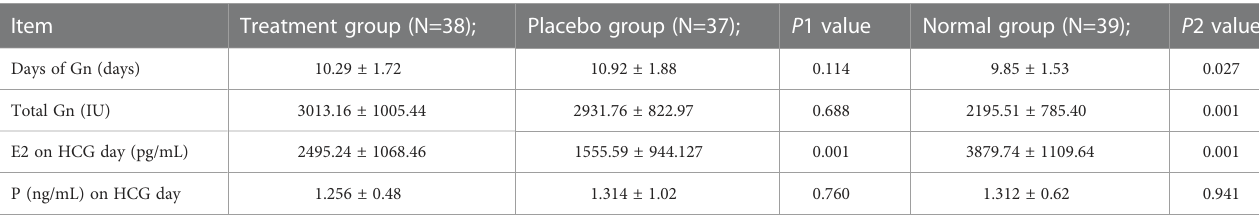
TABLE 2 Comparison of ovarian stimulation among three groups ( (cid:1) x ± s).